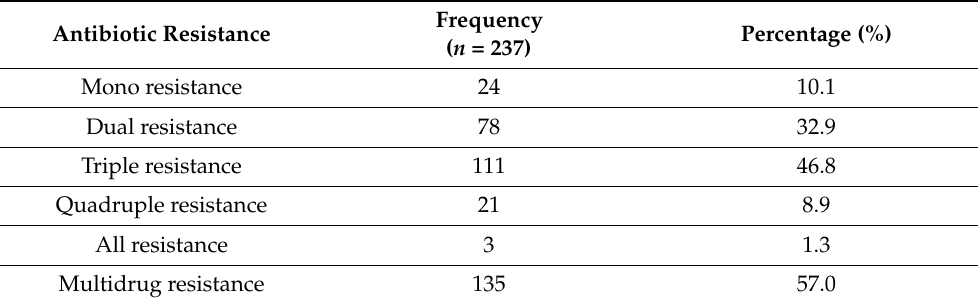
Table 2. The proportion of multidrug resistance to antibiotic agents in pediatric patients. Antibiotic Resistance